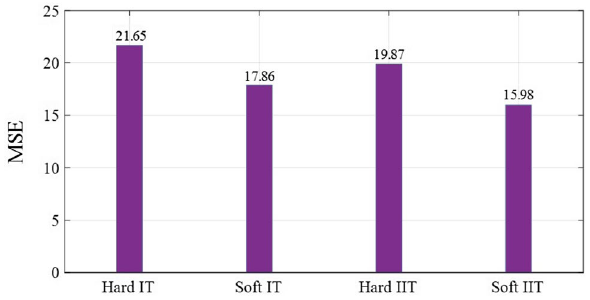
Fig. 9 MSE values for hard and soft interval thresholding (IT) and iterative interval thresholding